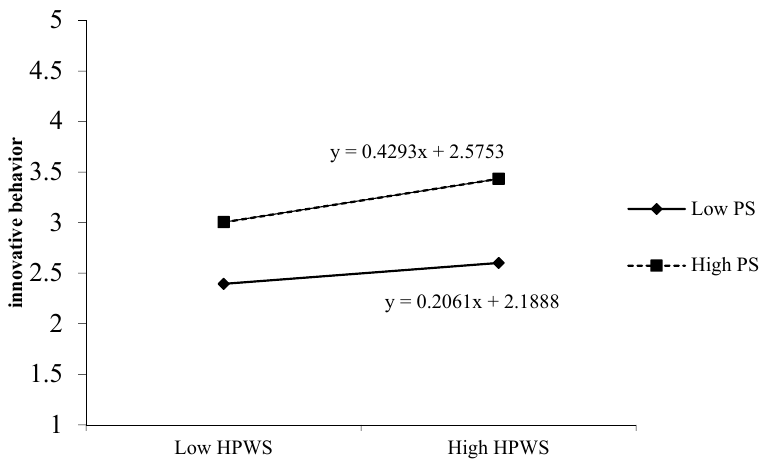
Figure 3. The interactive effect of HPWS and PS on innovative behavior.